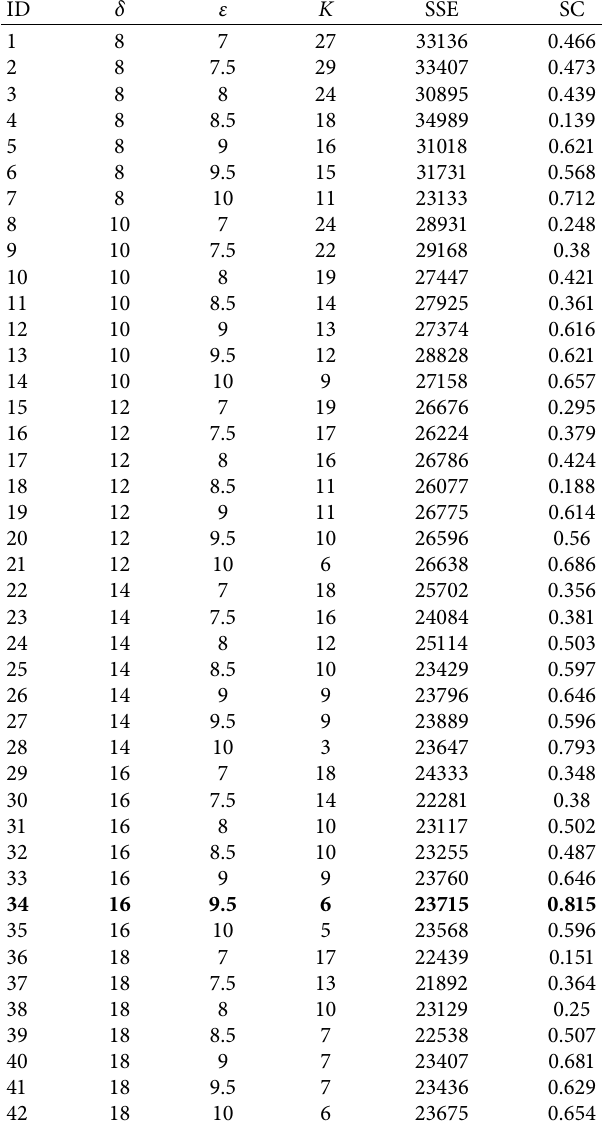
Table 3: The number of clusters and algorithm performance based on different